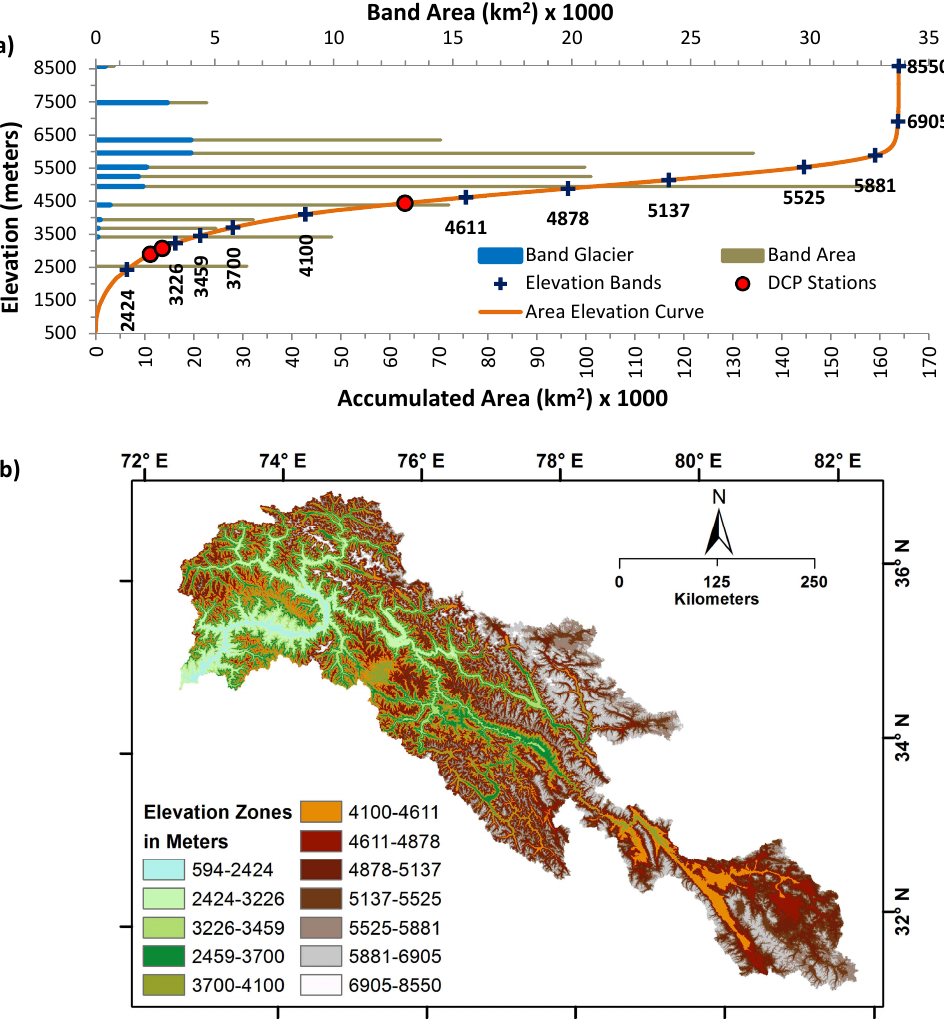
Figure 3. ( a ) Area elevation curve (AEC), along with the demarcation of considered elevation bands, height of used meteorological stations, band-wise surface area and glacier cover; ( b ) Spatial description of twelve elevation bands identified based on AEC. Note: The elevations are given in the unit of meters while the areas are given in the unit of 1000 km 2 .